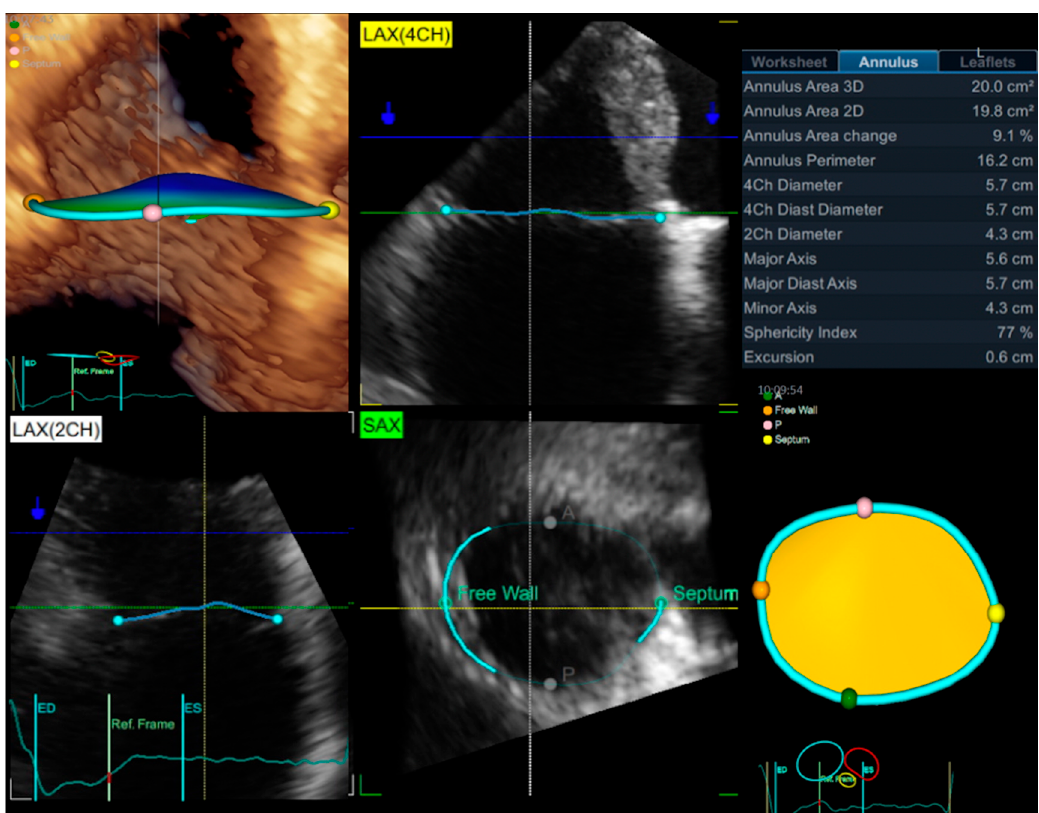
Figure 4. Evaluation of tricuspid annular size and shape by 4D Auto TVQ software ((EchoPac v204, GE, Horten, Norway). Abbreviations: 2Ch, apical 2-chamber view; 2D, two-dimensional echocardiography; 3D, three-dimensional echocardiography; 4Ch, apical 4-chamber view; A, anterior; ED, end-diastole; ES, end-systole; LAX, long axis; P, posterior; SAX, short axis.